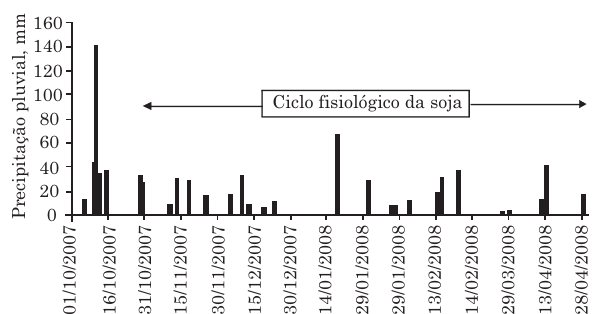
Figura 2. Precipitação pluvial observada durante o ciclo da soja , na safra 2007/08.